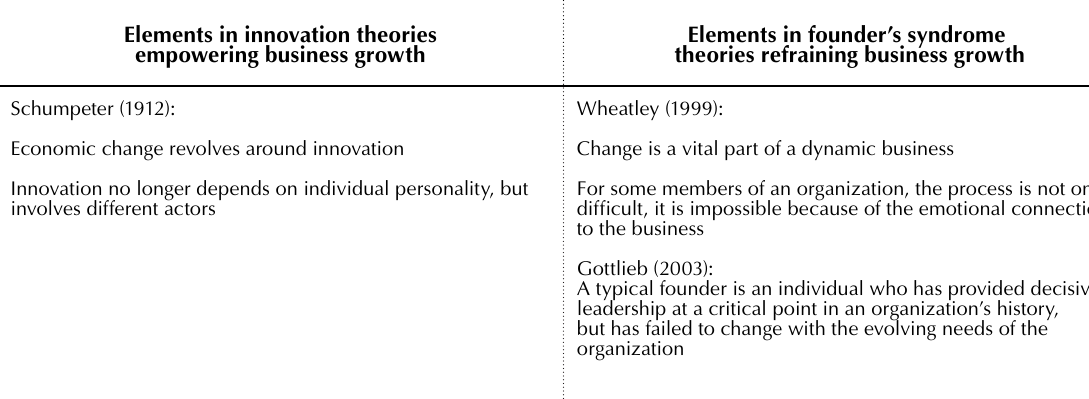
Table 1. Comparative